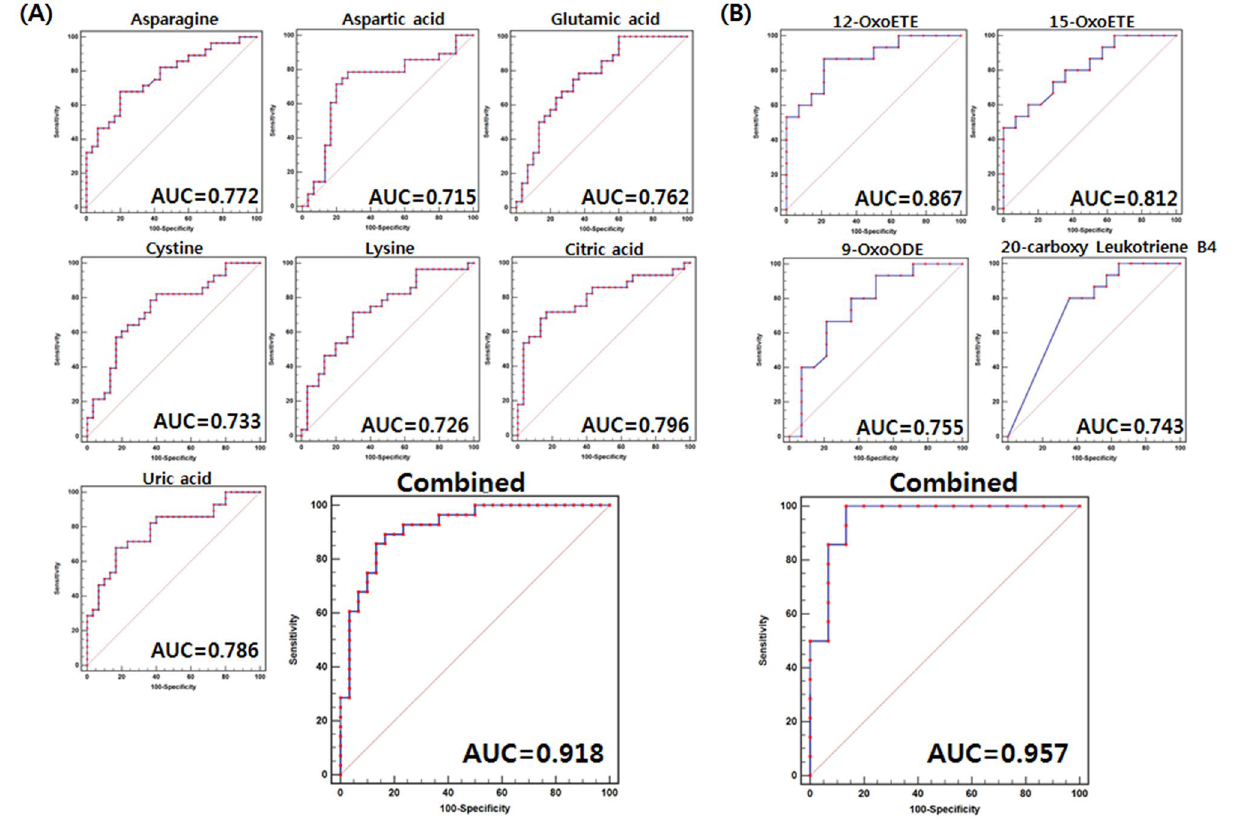
Figure 3. Receiver operating characteristic (ROC) curve of potential metabolite biomarkers distinguishing diabetic macular edema (DME) versus non-DME subjects, and combined ROC curves of those multi- biomarkers in discovery cohort. ( A ) 7 metabolites selected after GC–TOF–MS analysis-based metabolite profiling. ( B ) 4 oxylipins selected after lipid profiling analyzed by HPLC-triple-Q-MS. The ROC curves of each metabolite, and combined ROC curves, were overlain on single plots. The AUC values of each metabolite are shown inside the ROC ing good discriminatory power for DME versus non-DME subjects, with an AUC > 0.7 from discovery cohort. Among the assigned metabolites, glutamic acid, cysteine, asparagine, aspartic acid, lysine, uric acid, malic acid, citric acid, nonanoic acid, 15-oxo-eicosatetraenoic acid (oxoETE), 12-oxoETE, 20-carboxy leukotriene B4, and 9-oxo-octadecaidenoic acid (oxoODE) exhibited statistically significant different levels between the groups of subjects with DME and non-DME in both the discovery and extended cohorts (Table S1, S3-S5). ROC curves were also generated for the 109 assigned metabolites using the relative metabolite levels of the experimental group in the discovery cohort (Table S1 and S3). Among them, metabolites which exhibited good discrimina- tory power for diabetic versus DME cases with an AUC > 0.7 included glutamic acid (0.762), cysteine (0.733), asparagine (0.772), aspartic acid (0.715), lysine (0.726), uric acid (0.786), citric acid (0.796), phenylacetic acid (0.810), 15-keto prostaglandin F2α (0.750), 15-keto prostaglandin E2 (0.719), 15-oxoETE (0.812), 12-oxoETE (0.867), 20-carboxy leukotriene B4 (0.743), 9-oxoODE (0.755), and ( ±) 9-hydroxyoctadecadienoic acid (HODE) or ( ±) 13-HODE (0.743). Finally, multi-biomarkers selected for distinguishing DME patients from non-DME